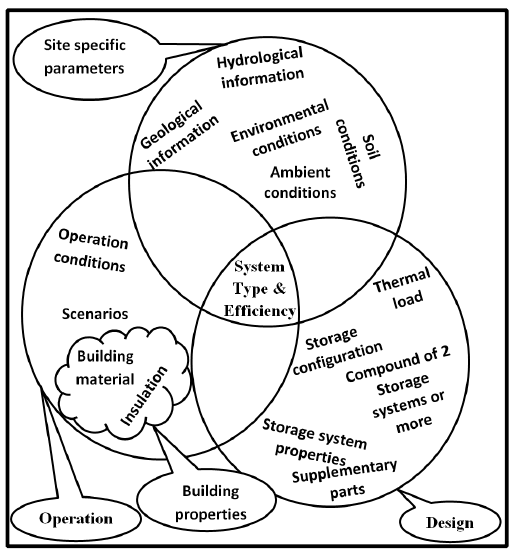
Figure 1. Factors e ff ecting underground thermal energy storage (UTES) system type and e ffi Figure 1. Factors effecting underground thermal energy storage (UTES) system type and efficiency.